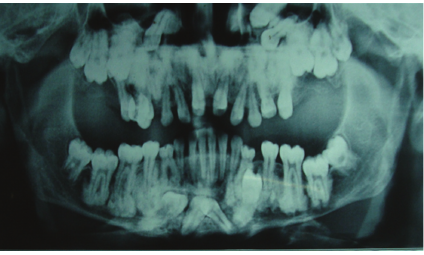
Figure 2: Intraoral photograph showing high frenal attachment (Case 1).